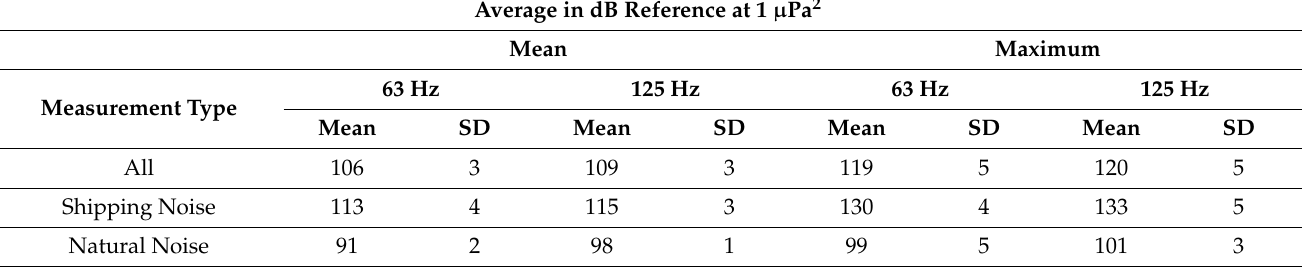
Table 2. Average and standard deviation of the mean and maximum values of the 1/3 octave bands centered at 63 and 125 Hz for all shipping and natural noise measurements.